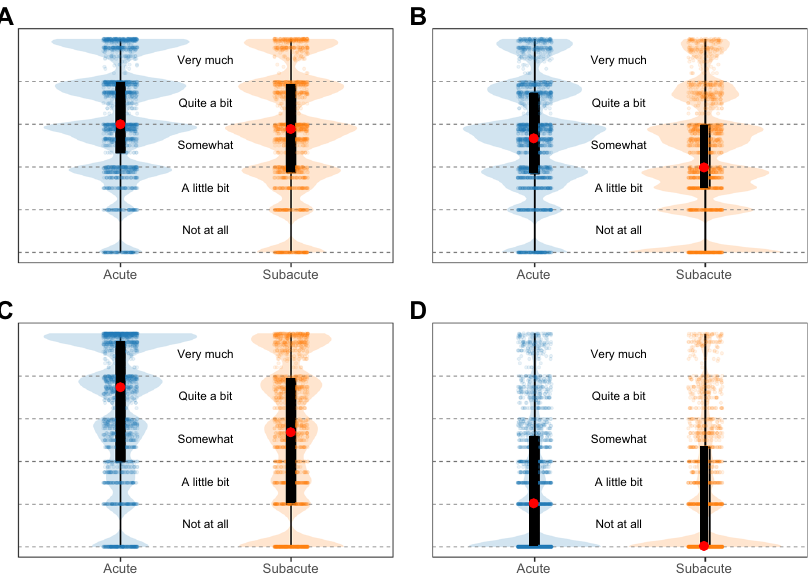
Fig. 2 Violin plots demonstrating the distribution of Toxicity Index in the acute (blue) and subacute (orange) time periods for each symptom domain. Red circles represent the median, and black bars represent the interquartile range. A pain. B cognition. C vasomotor. D